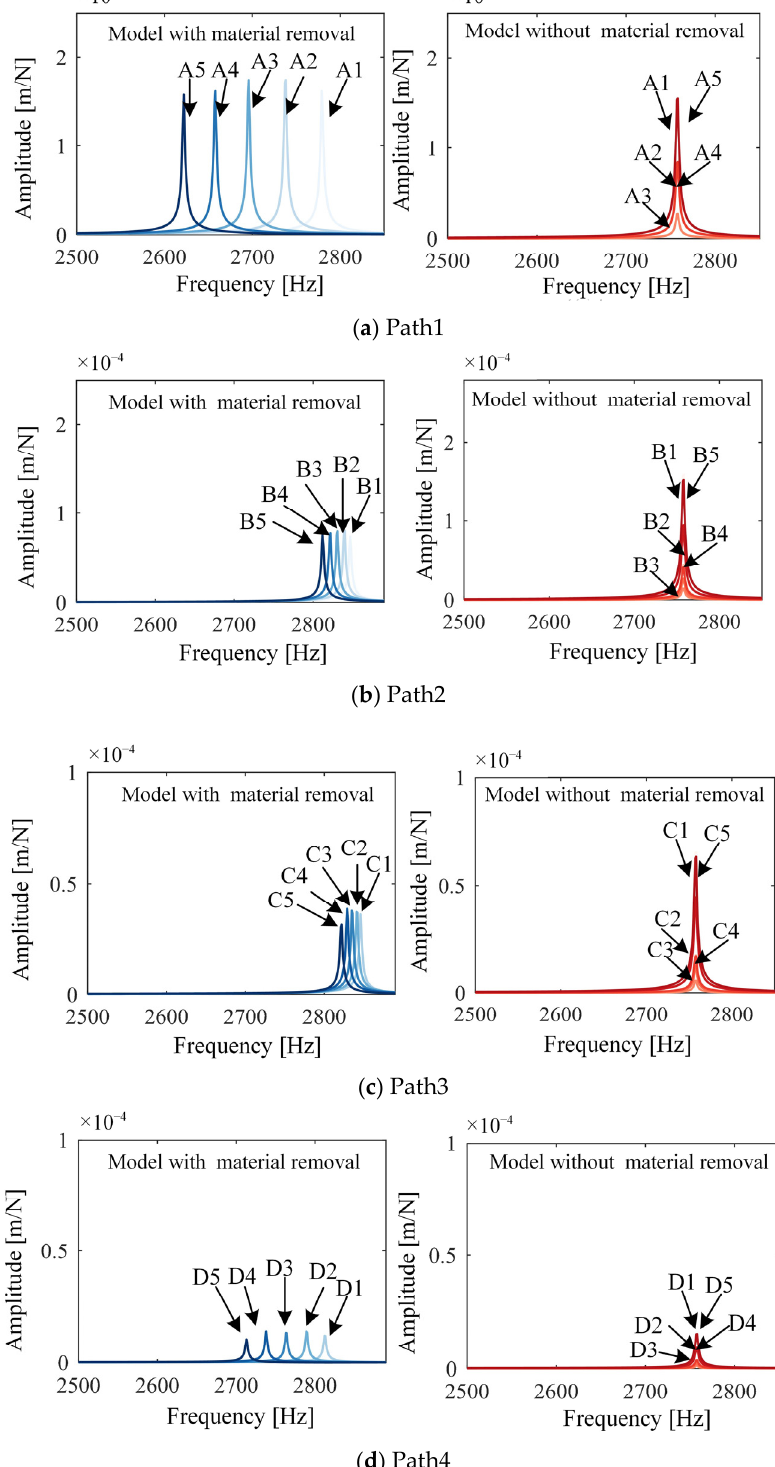
Figure 13. FRF comparison between two models.